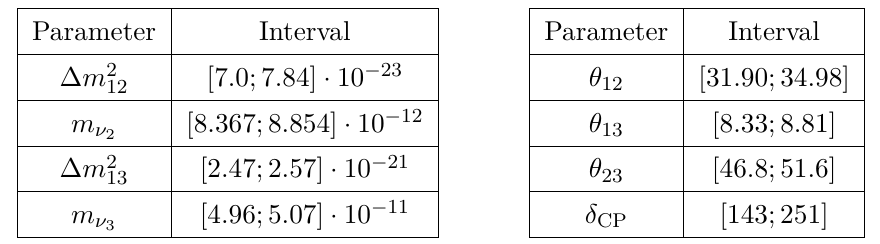
Table 3 . Intervals at the 2 σ confidence level for the neutrino masses and mixing parameters extracted from global fits of experimental neutrino data [48]. The neutrino masses are given in GeV, the angles and phases entering the PMNS matrix are given in